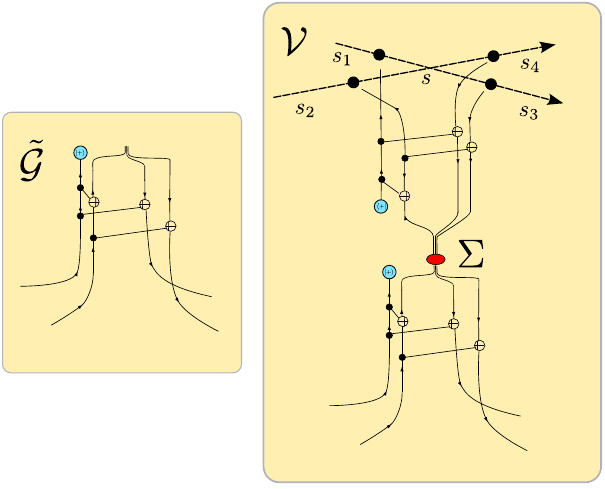
~ G FIG. 21. Left: The isometry can be used to go to the gauge- invariant states. Now, a diagonal operator in this space commutes with the gauge transformations and is thus gauge invariant. Right: The vertex operator described in Eq. (45) is built by concatenat- ~ G ing the tensor , a diagonal tensor Σ (a red circle) [acting on C ð G Þ 3 ], and then ~ G † . It acts as a potential for different gauge- invariant configurations and allows us to favor one with respect to